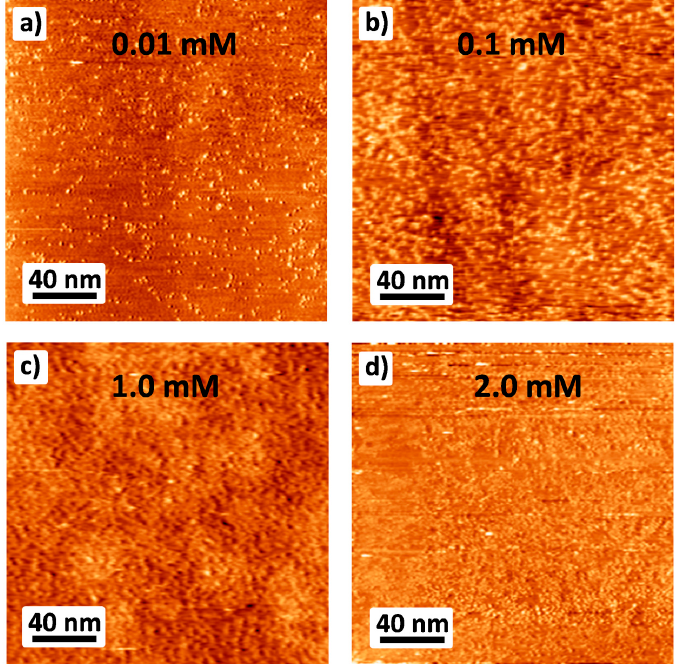
Figure 4. High-resolution STM images recorded with respect to samples grafted by different 3,5-TFD concentrations. Tunneling parameters ( a ) I set = 0.1 nA, V bias = 0.5 V; ( b ) I set = 0.12 nA, V bias = 0.6 V; ( c ) I set = 0.08 nA, V bias = 0.5 V; ( d ) I set = 0.12 nA, V bias = 0.7 V.